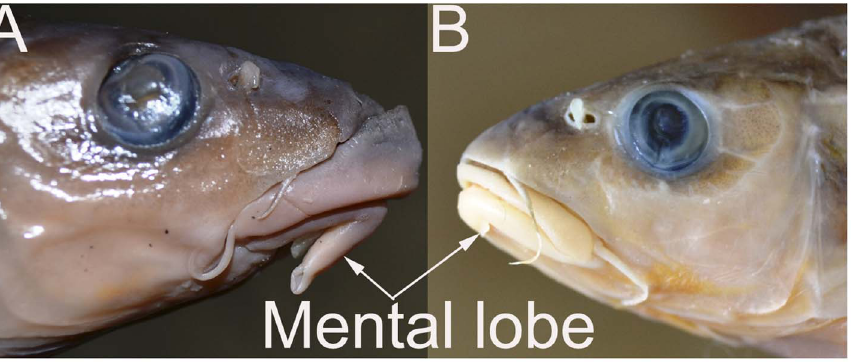
Figure 4. Illustrating the counter appearances of mouth in (A) T.progeneius and (B) T.putitora . Showing fleshy lips, a semicircular flap extending behind the upper lip, and a fleshy appendix extending from the lower lip up to the margin of maxilla (very long mental lobe) in (A), but absent in (B).